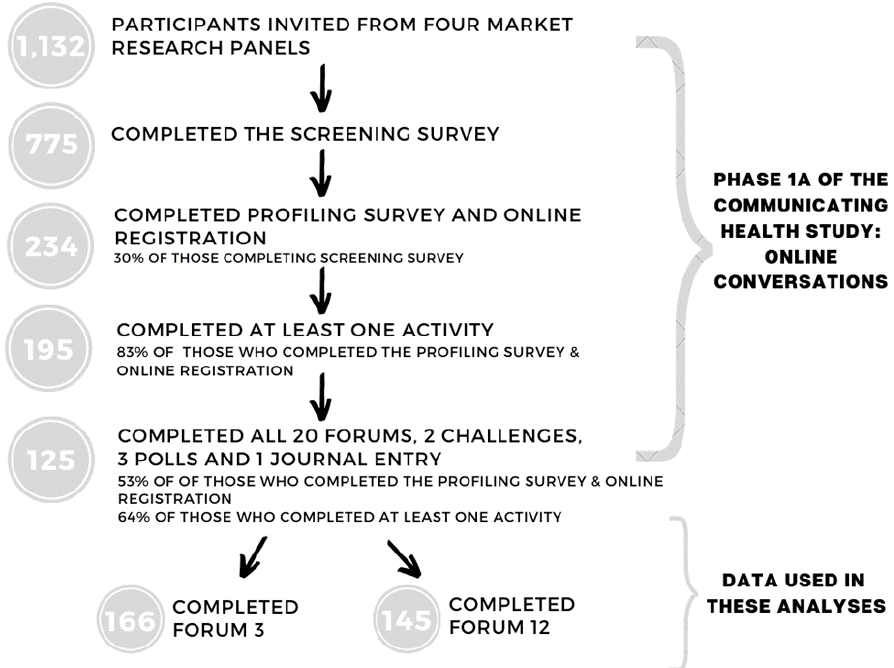
Figure 1. Communicating Health online conversations study flow diagram.